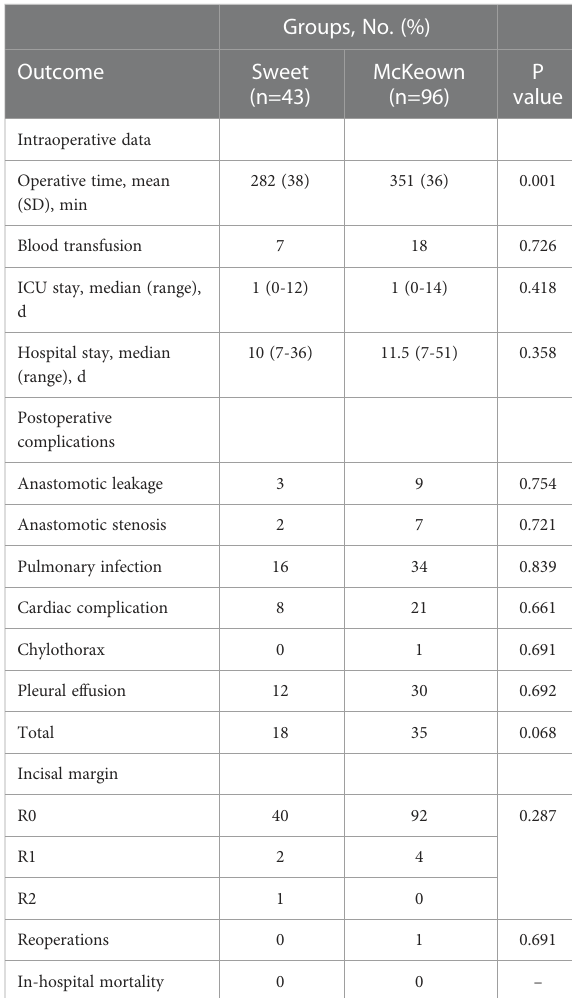
TABLE 3 Postoperative